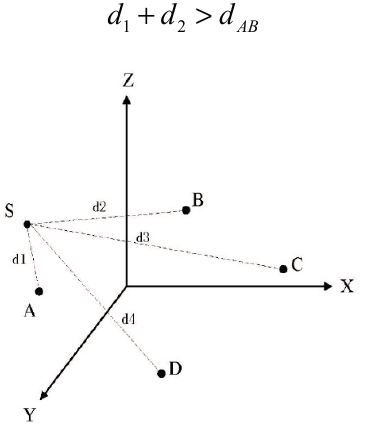
Figure 4. Passive Hyperboloid Localization Algorithm (PHLA)